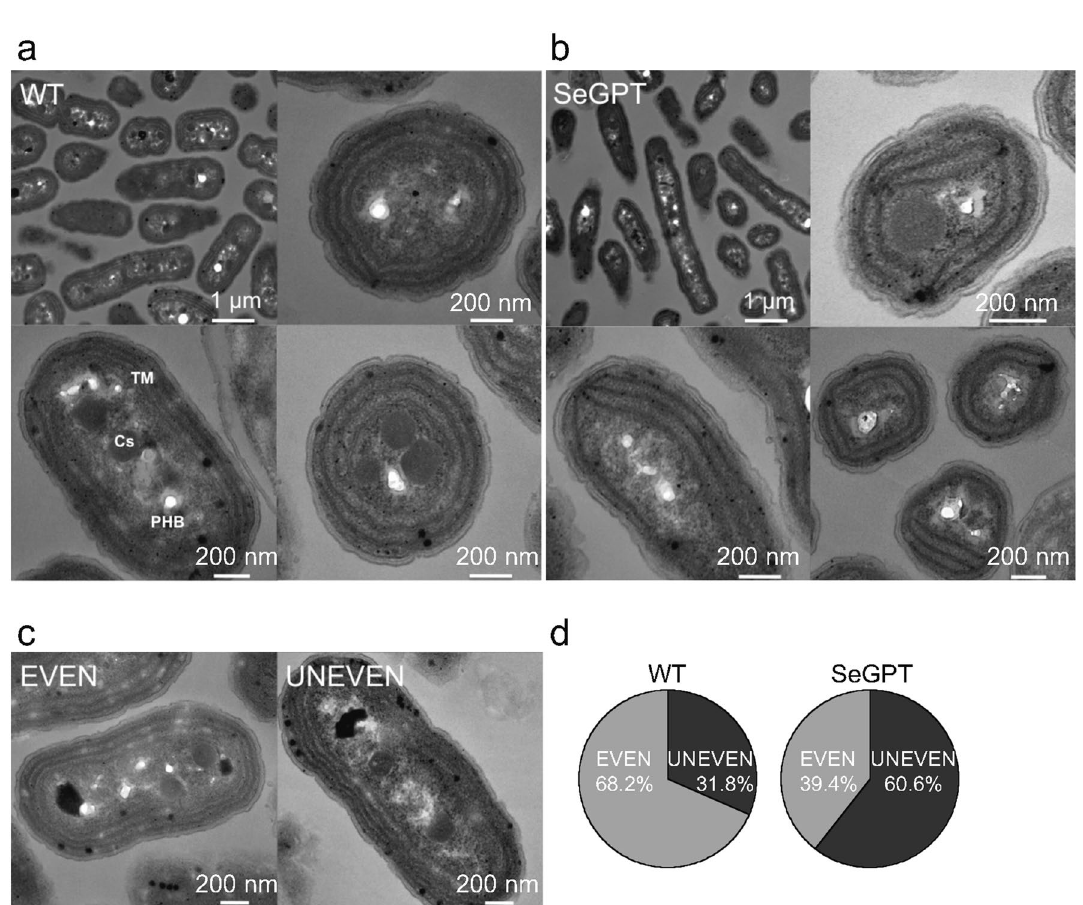
Figure 3. Transmission electron microscopic images of the WT ( a , c ) and SeGPT. ( b ) Carboxysomes (Cs), polyhydroxybutyrate (PHB), and thylakoid membrane (TM) ( a ). ( c ) The representative images of cells in which the thylakoid membrane is evenly developed in the cell (EVEN) and those in which it is unevenly developed (UNEVEN). ( d ) The percentages of EVEN and UNEVEN cells are compared between WT and SeGPT. Scale bars: 200 nm or 1